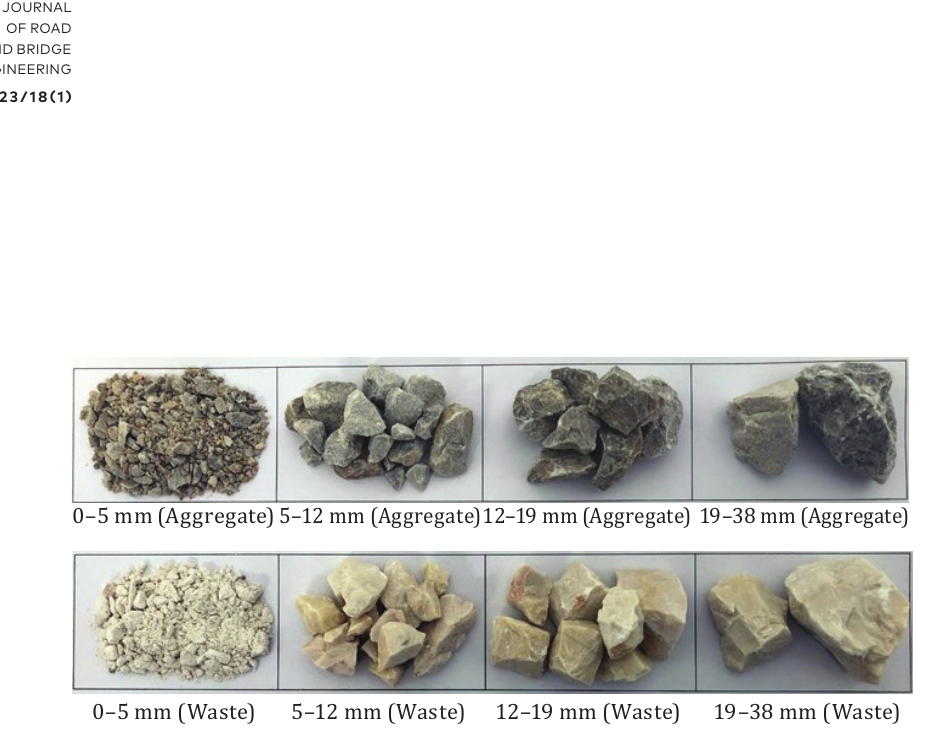
Figure 8. Aggregate and marble waste samples